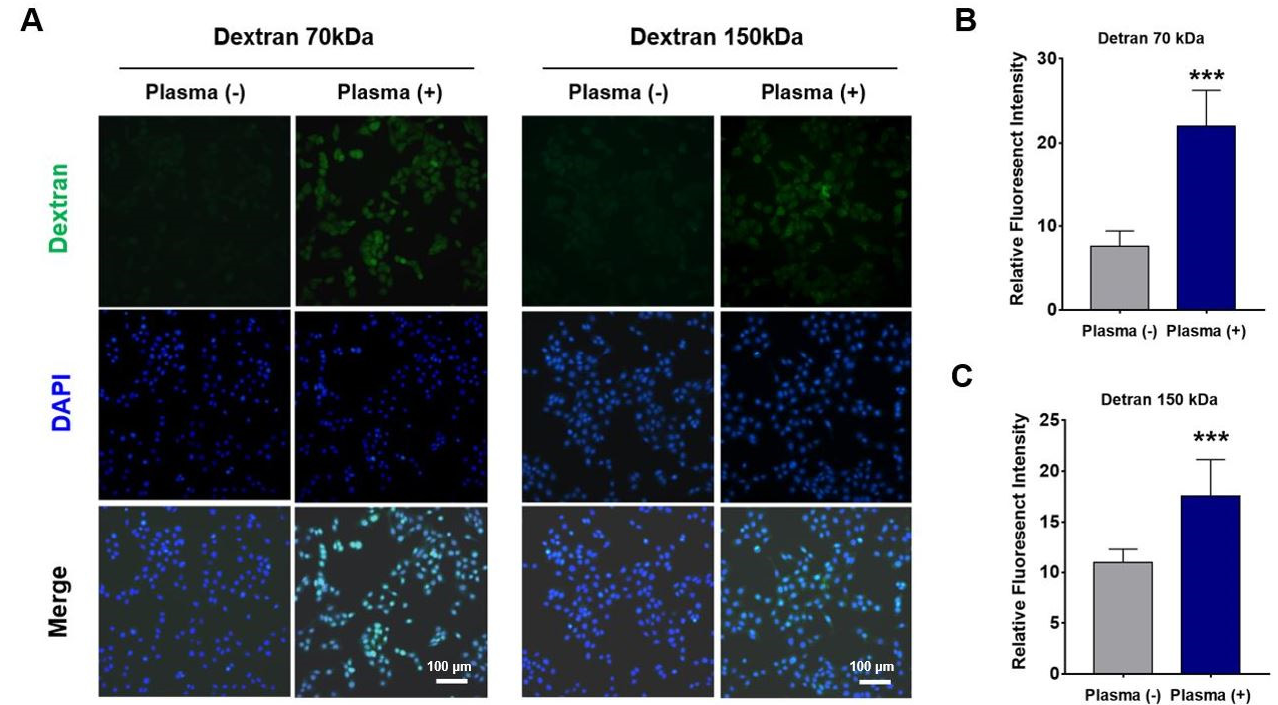
Figure 7. Cellular permeability of 70 kDa and 150 kDa dextran by argon plasma irradiation in keratinocytes. ( A ) Fluorescence images, HaCaT cells were treated with argon plasma for 30 s and then subjected to fluorescein-dextran 70 or 150 kDa. ( B , C ) Statistical results of relative fluorescence in the cells treated with 70 kDa ( B ) and 150 kDa ( C ) dextran in the presence and absence of argon plasma irradiation. Scale bar indicates 100 µ m. The fluorescent intensity was averaged from 40 cells. Data are presented as means ± S.D. *** p < 0.001 compared to the nontreated control (unpaired two-tailed t test).